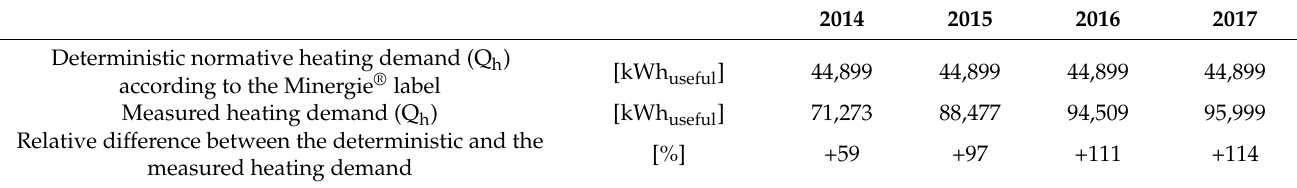
Table 2. Comparison of the normative heating demand according to the energy-efficient label Minergie ® and the measured heating demand for the first four years of operation (2014–2017).